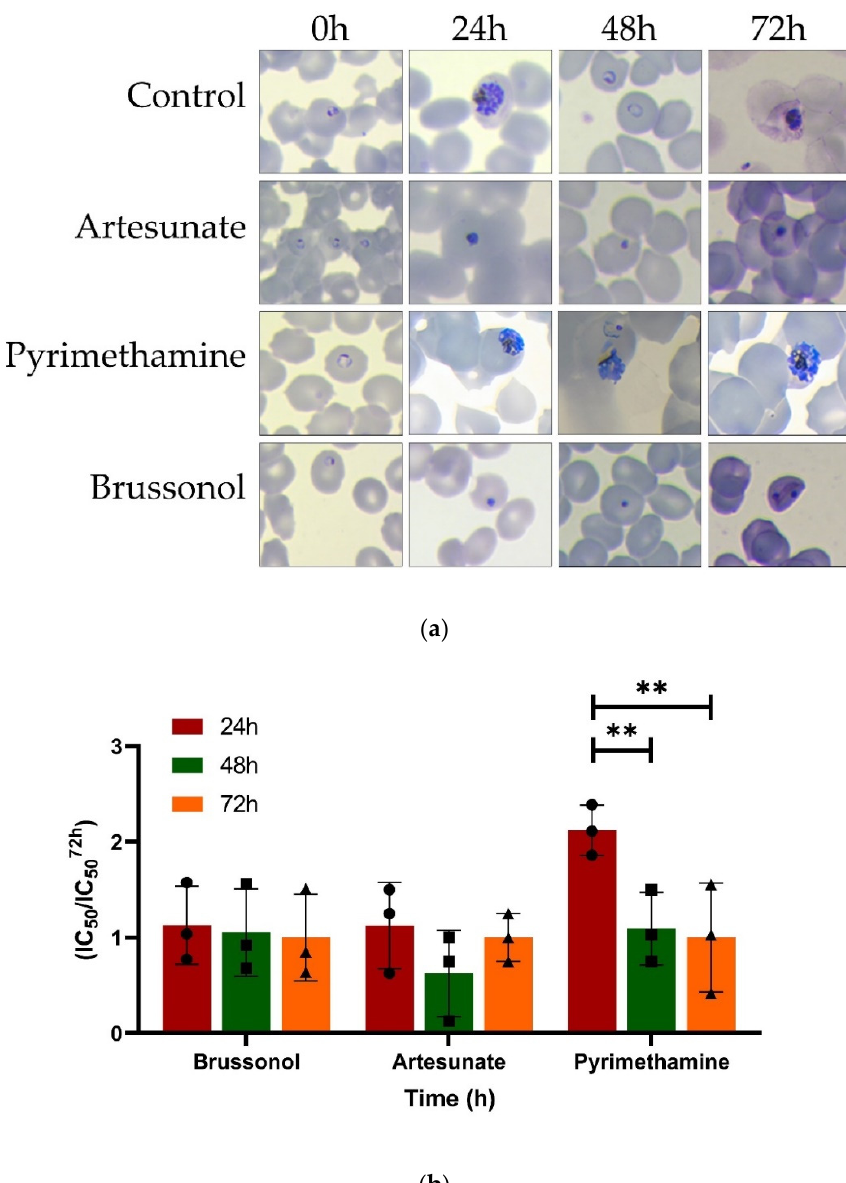
Figure 5 . Speed-of-action assessment of brussonol. ( a ) Morphological development evaluation of parasites over time in P. falciparum culture stained with giemsa. ( b ) IC 50 values were determined at 24, 48, and 72 h. Artesunate and pyrimethamine were used as a positive control for fast- and slow-acting inhibition, respectively. The results were normalized with respect to the assessed IC 50 value at 72 h. Statistical analysis was carried out by using ANOVA (** p < 0.01; a p -value < 0.05 indicates a significant difference within samples). These data correspond to three independent experiments, mean IC 50 ±